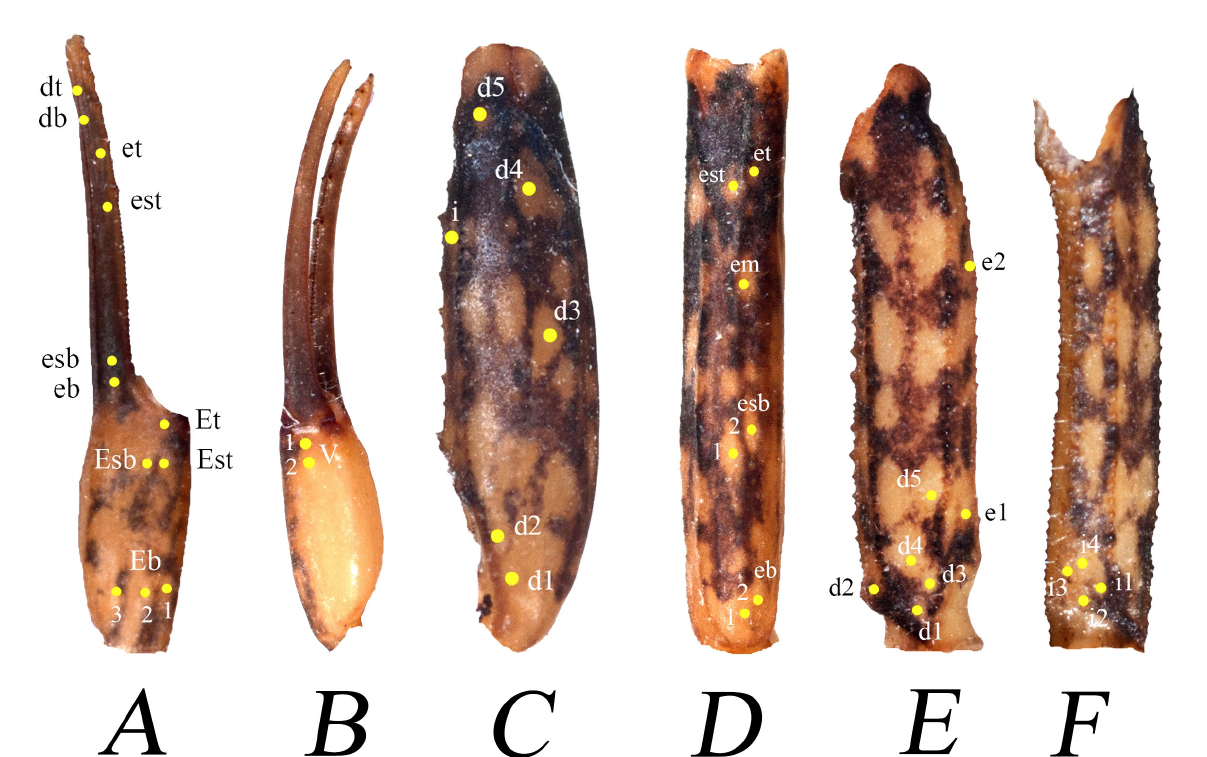
Fig. 6. Isometrus sankeriensis Tikader & Bastawade, 1983, neotype, adult ♂ (BNHS SC 194). A–B . Pedipalp chela. A . Dorsal view. B . Ventral view. C–D . Patella. C . Dorsal view. D . External view. E–F . Femur. E . Dorsal view. F . Internal view. Trichobothrial pattern indicated by yellow